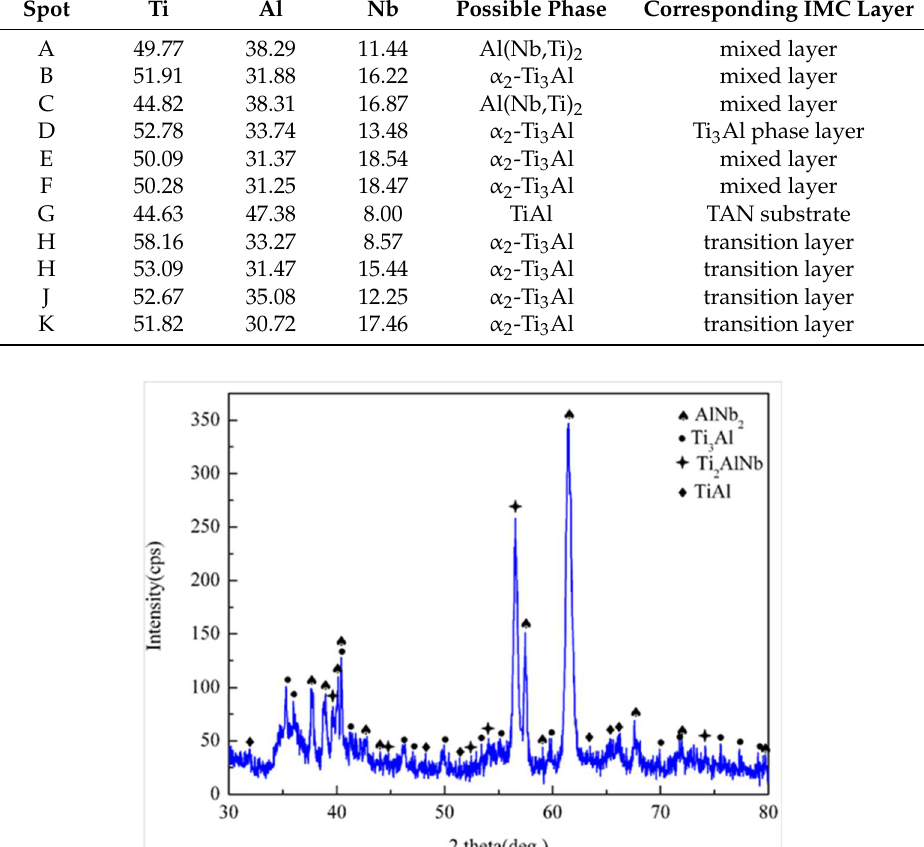
Table 3. Chemical compositions and possible phases of each spot marked in Figure 7 (atom %).